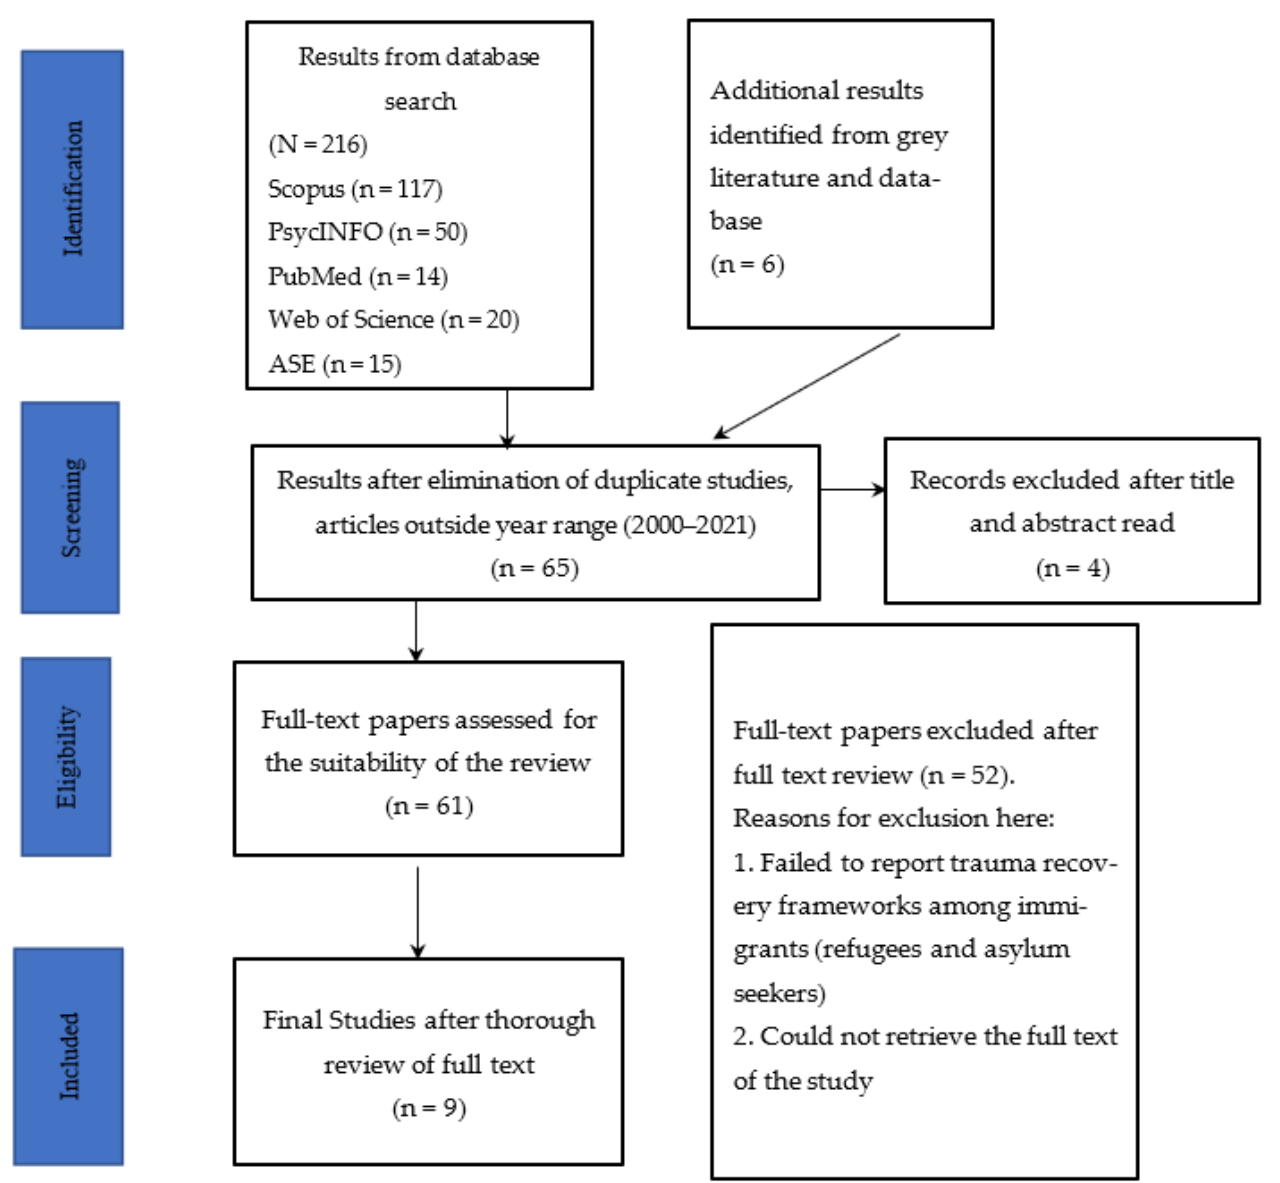
Figure 1. Summary of the article filter process leading to the included studies.